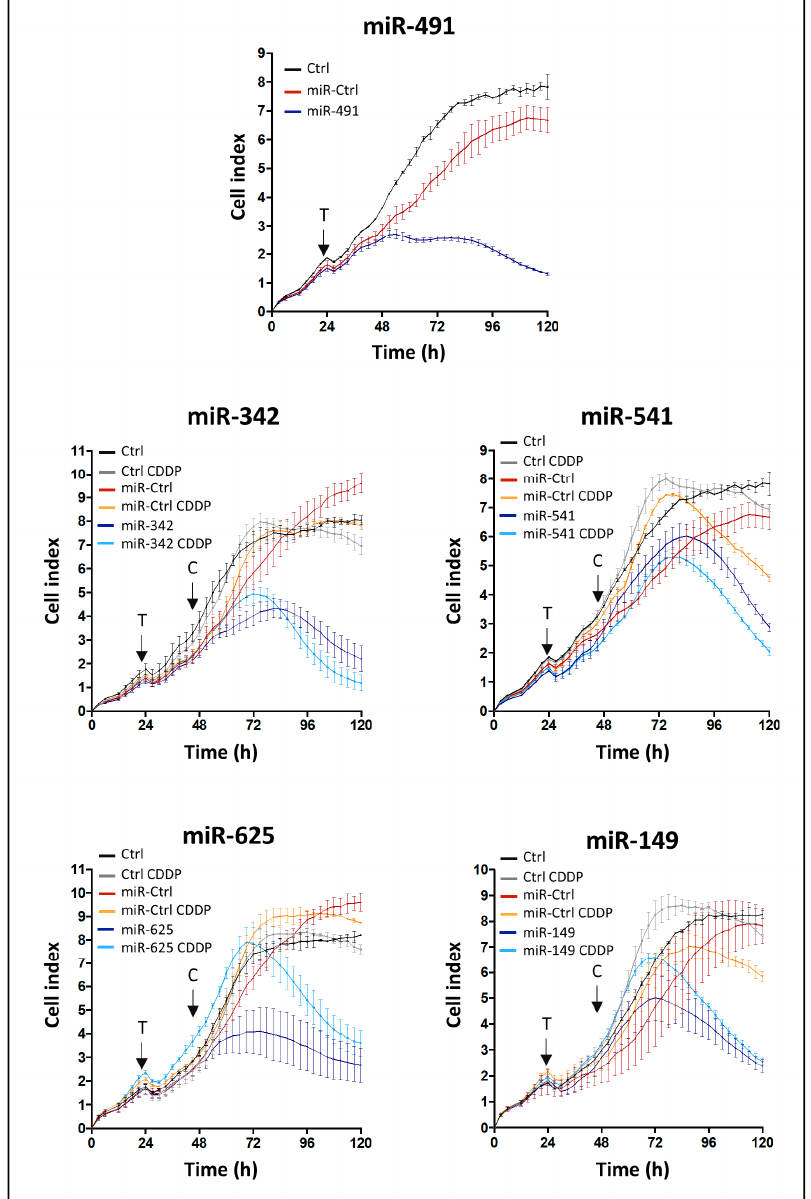
Figure 1. Identification of miRNAs with potential antiproliferative and chemosensitizing effects using high-throughput screening. SW1353 cells were seeded in triplicate in 96-well E-plates VIEW. They were grown for 24 h before transfection (arrow labeled with a T) with 20 nM of miR-Ctrl, miR-491-5p, miR-342-5p, miR-541-5p, miR-625-5p or miR-149-5p. The cells were also treated with 1 µg/mL of CDDP 24 h post-transfection or left untreated (arrow labeled with a C). Each condition was performed in triplicate. Real-time growth curves were monitored using the xCELLigence System. Impedance was recorded every 2 h for 120 h. Cell index profiles of one experiment per miRNA species, with mean ± SD, are shown. CDDP: cisplatin, Ctrl: control.